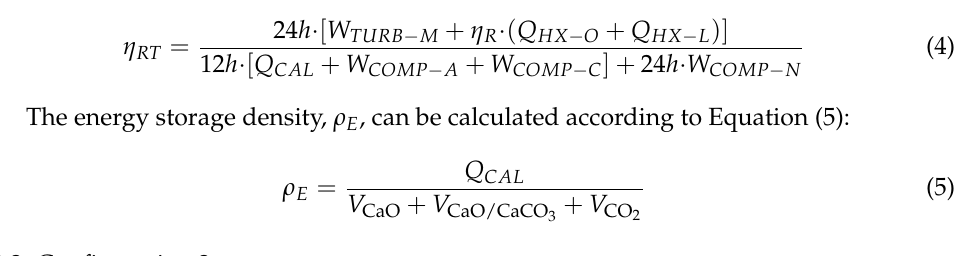
Table 1. Summary of base case process conditions for Con fi guration 1.